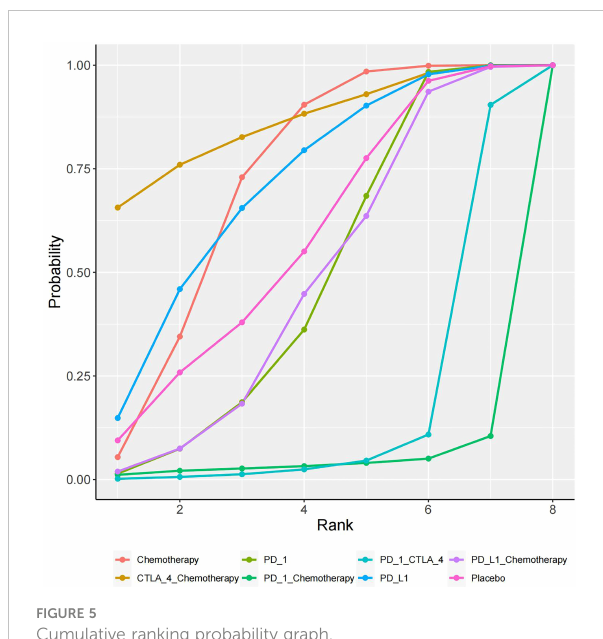
FIGURE 5 Cumulative ranking probability